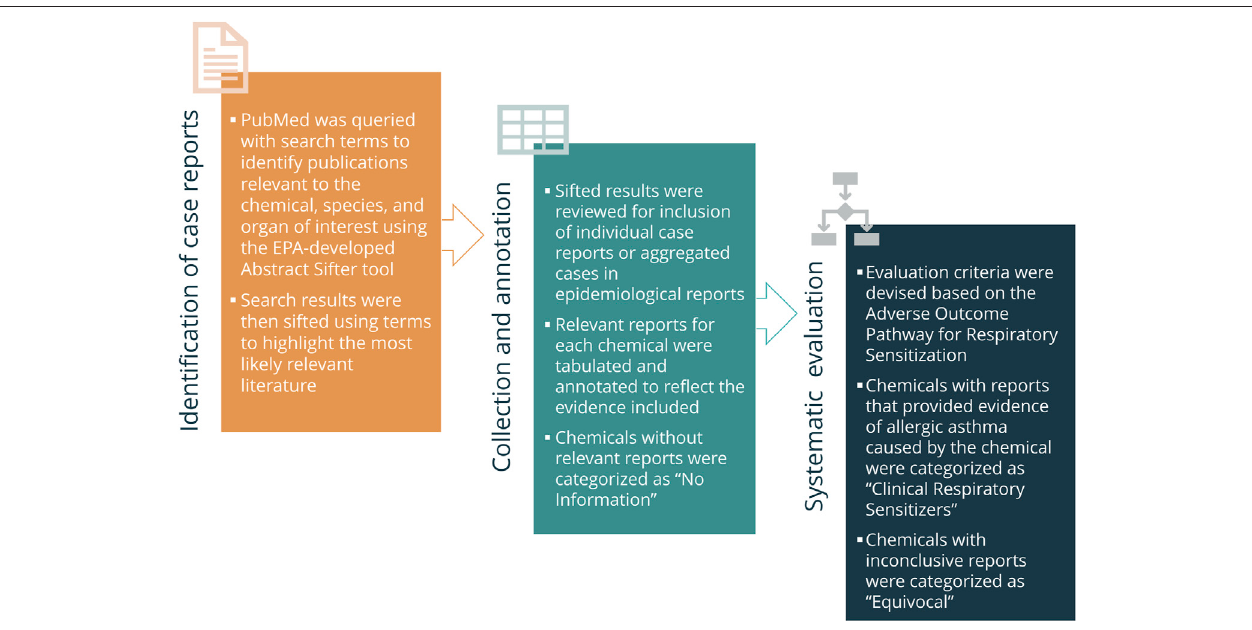
FIGURE3| Generalized “ InLitero ” screeningapproach.Inordertoidentifyclinicalliterature,AbstractSifterwasusedtocollectand “ sift ” themostrelevantresultsto the top. Reports referring to clinical cases of occupational asthma associated with each chemical were tabulated and annotated. Chemicals for which relevant reports could not be identi fi ed were categorized as “ No Information ” and excluded from evaluation. The reports for the remaining chemicals were categorized according to the established evaluation criteria as “ Clinical Respiratory Sensitizers ” or “ Equivocal ”